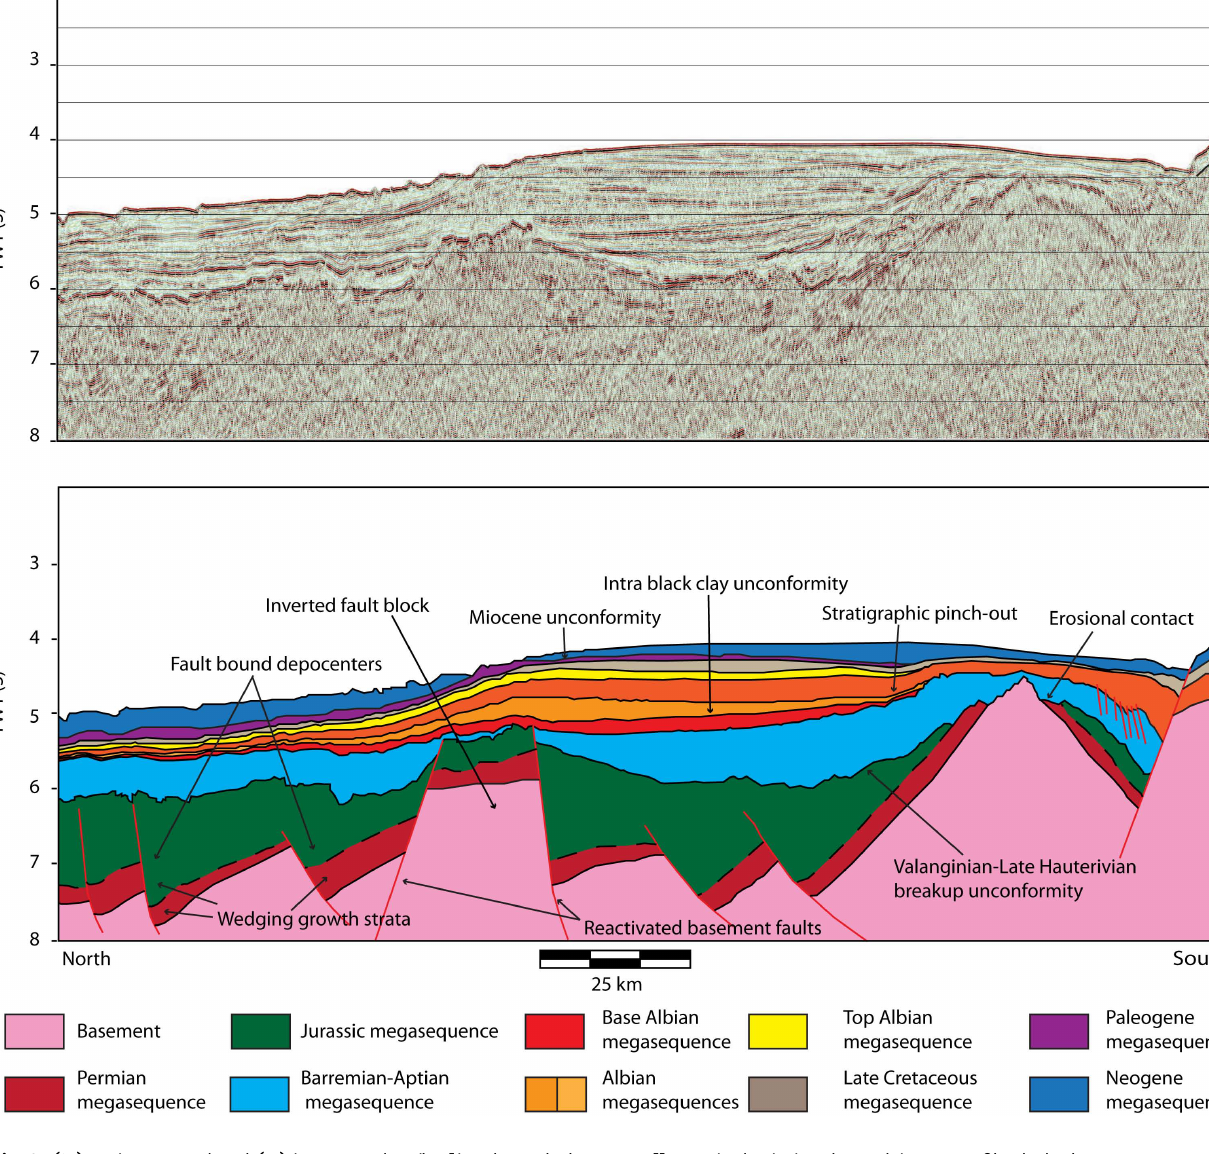
Fig. 6. (A) Uninterpreted and (B) interpreted strike line through the Mentelle Basin depicting the architecture of both the basement structure and seismically defined megasequences. Note the presence of a large inverted basement fault block situated close to the centre of the strike